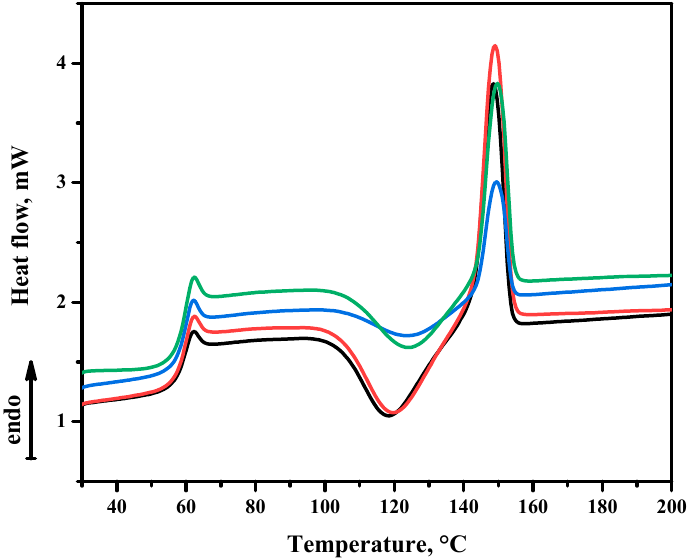
Figure 4. Differential scanning calorimetry of PLA and the obtained composites. PLA sample corresponds to the black line, PLA + 0.3 wt.% of MXene to the red line, PLA + 1 wt.% of MXene to the blue line and PLA + 5 wt.% to the green line.